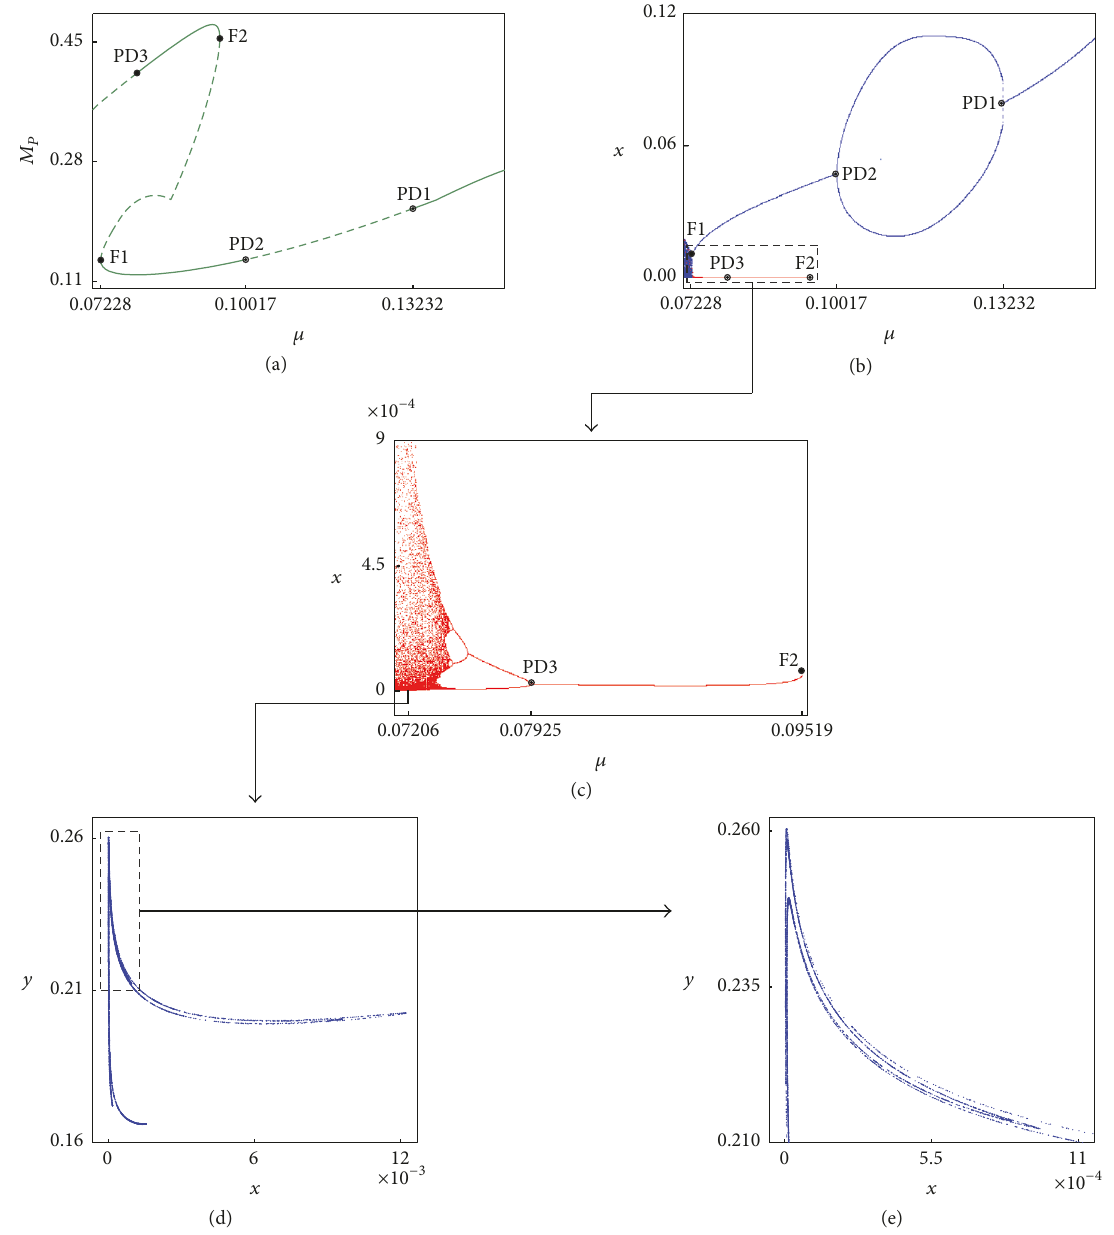
Figure 5: Dynamical behavior of the pest control method modeled by system (14), computed for the parameter values shown in Table 1. (a) Numerical continuation of the periodic response of the model with respect to the predator’s mortality rate 𝜇 . The points labeled PD 𝑖 and F 𝑖 denote period-doubling and fold bifurcations of periodic orbits, respectively. (b) Bifurcation diagram computed via direct numerical integration of system (14). The red and blue colors mark the parameter sweeps in the increasing and decreasing directions, respectively. (c) Blow-up of a part of the bifurcation diagram shown in (b). (d) Poincar´e map associated with a chaotic attractor computed for 𝜇 = 0.07206 . (e) Enlargement of a portion of the attractor displayed in